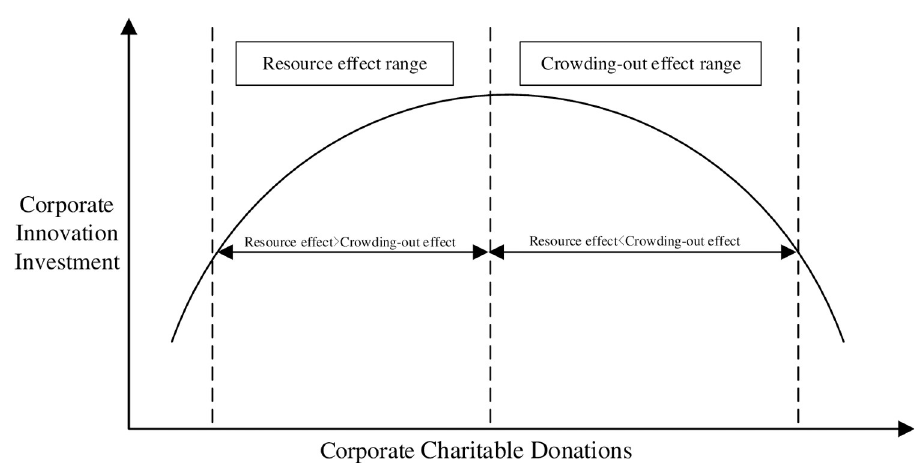
Fig 2. Mechanism of altruistic motivation oriented charitable donations on innovation